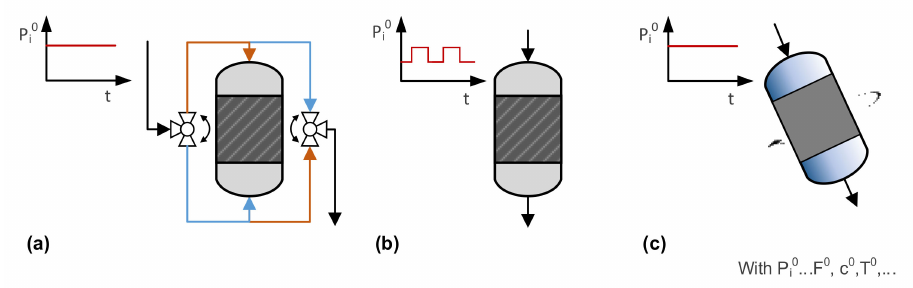
Figure 7. Selected strategies for dynamic operation modes of fixed-bed reactors: ( a ) reverse flow reactors, ( b ) reactors with inlet modulation, and ( c ) rotating